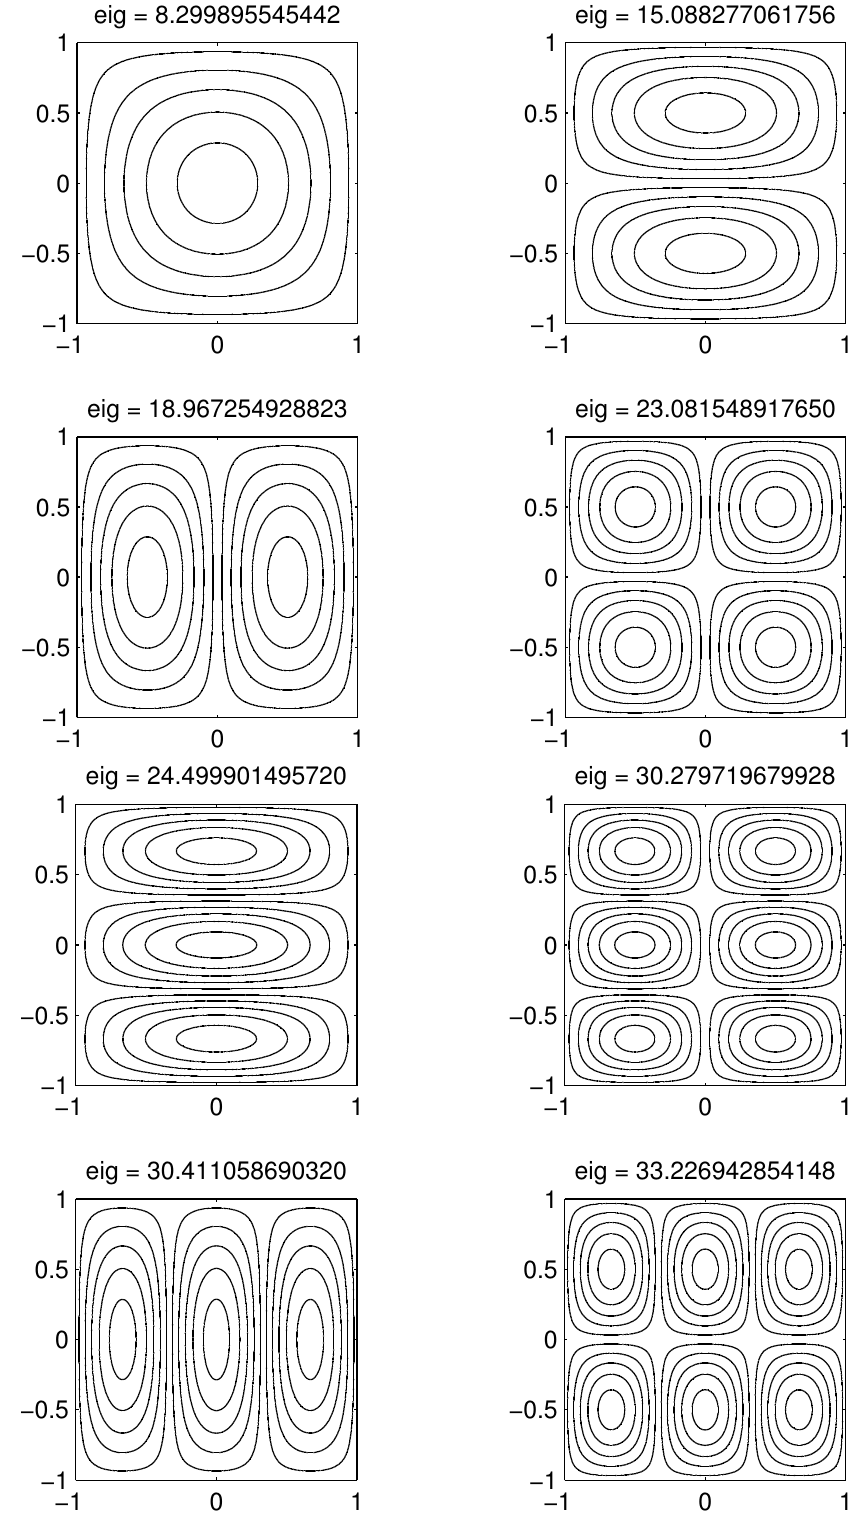
Figure 2: First eight vibration modes of the simply-supported cross-ply laminated square plate [0 ∘ /90 ∘ /90 ∘ /0 ∘ ] , E 1 / E 2 = 10 , 13×13